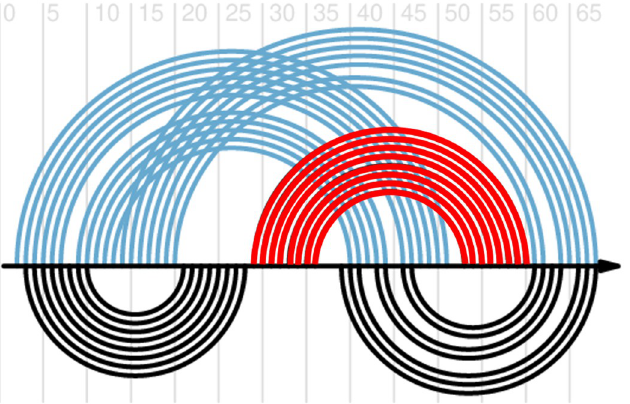
Fig 4. Initial stem 2 suboptimal structure. Predicted structures for the SARS-CoV-2 − 1 PRF stimulating pseudoknot with initial Stem 2 (in red) as constraint. Blue arcs correspond with the minimum free energy structure, black arcs represent a suboptimal structure with only slightly higher free energy. Visualization generated using R-chie web server [71].